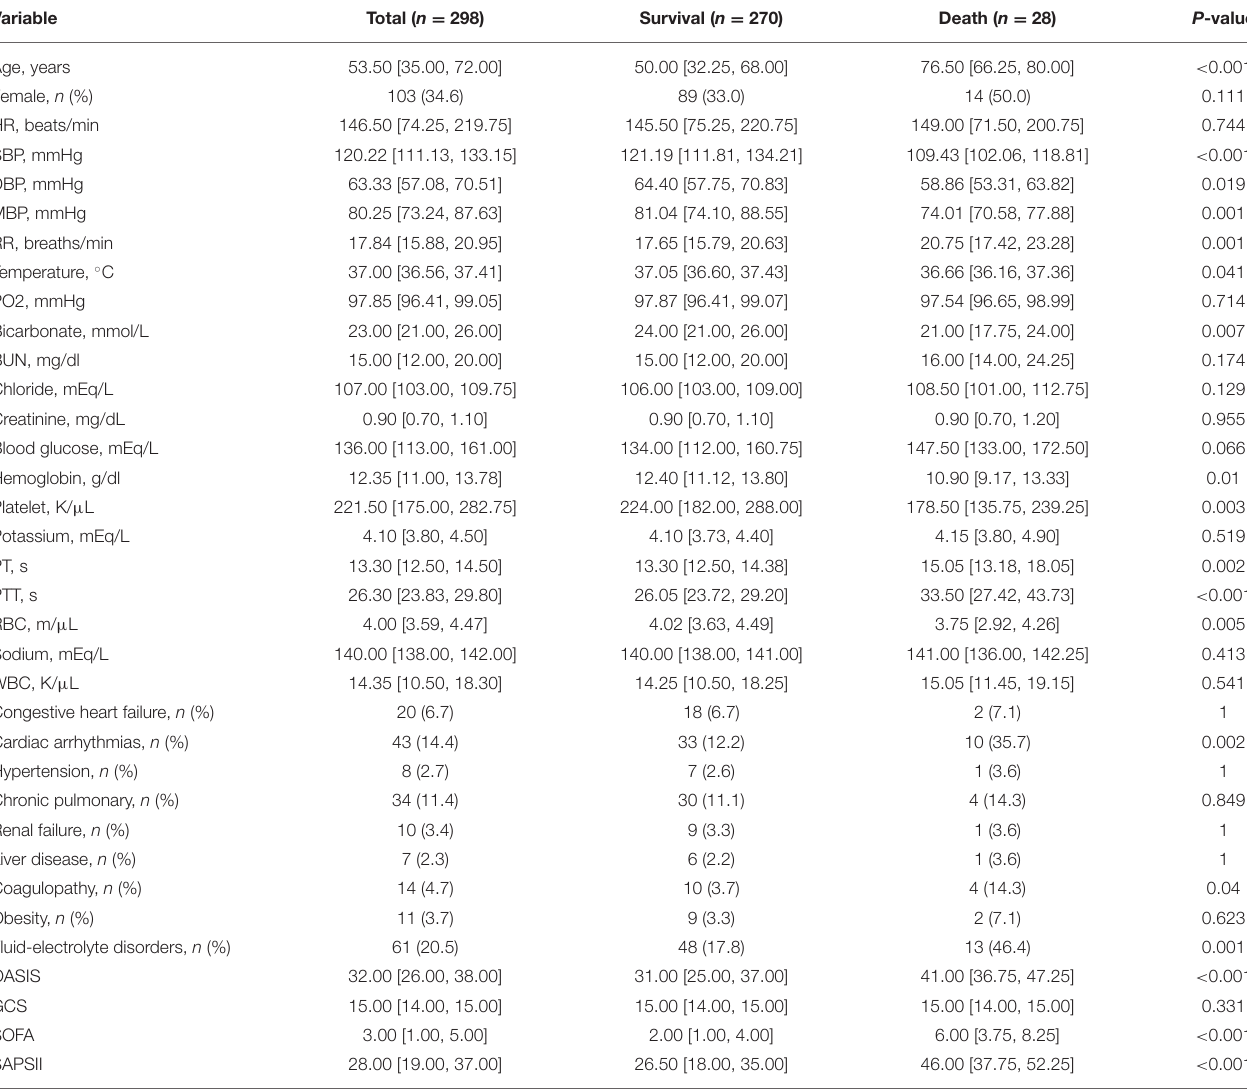
TABLE 1 | Baseline characteristics of in-hospital death and survival groups. Variable